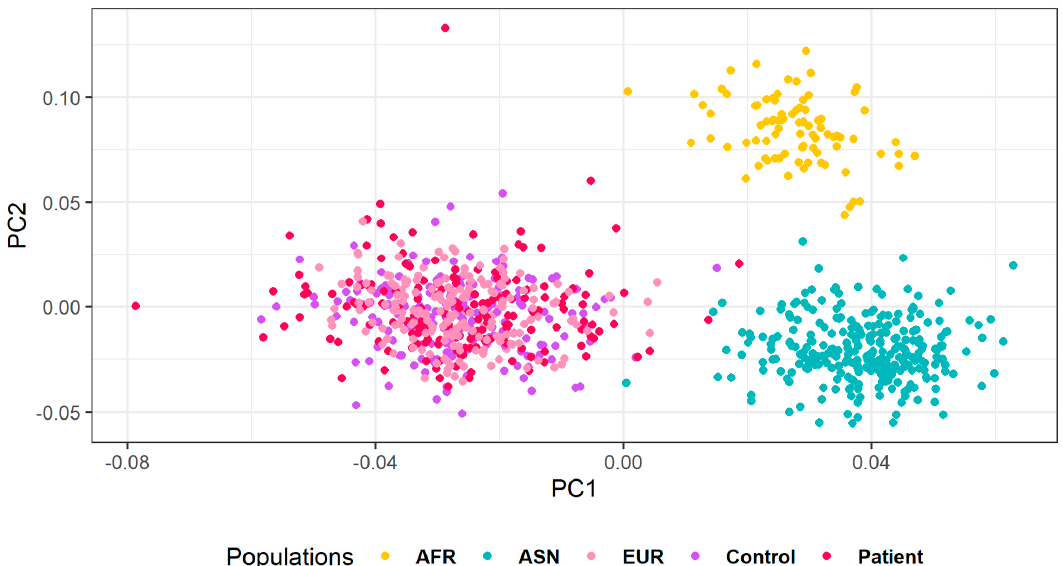
Figure 2. Principal component analysis (PCA) analysis for the SNPs in patients, controls, and African (AFR), Asian (ASN), and European (EUR)